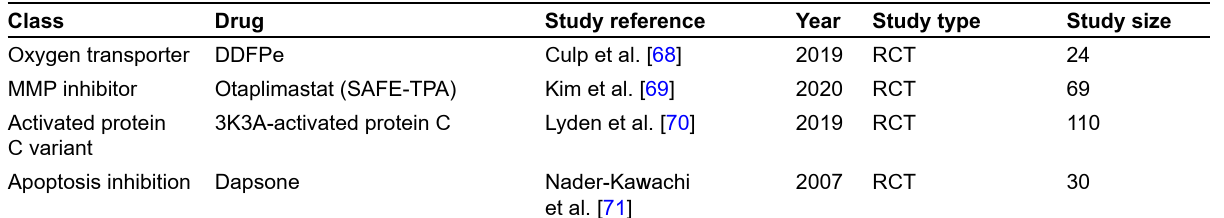
Table 2. Characteristics of human trials on neuroprotective agents in AIS ( continued ) Class